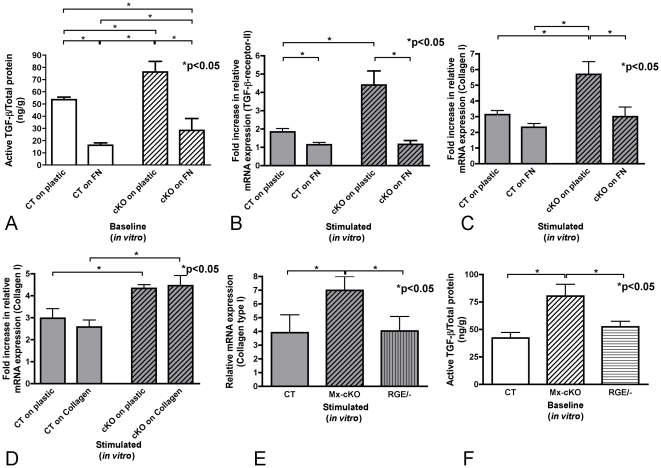
Fibronectin normalizes the responsiveness of cKO cells.(A) Active TGF-β in the medium decreases significantly both in control and Mx-cKO cells in the presence of fibronectin coating. Stellate cells were cultured directly after isolation for 24 hours on plates left uncoated or coated with fibronectin, media were changed and collected after an additional 24 hours in culture (using 10% fibronectin-depleted FCS). N = 5 wells/group. (B) Fibronectin coating is associated with a decrease in TGF-β-receptor-II mRNA expression in response to TGF-β stimulation in Mx-cKO cells. Isolated cells were cultured on plastic or on fibronectin for 24 hours, then left untreated or treated with 10 ng/ml TGF-β for an additional 24 hours after which mRNA was collected. Data presented are adjusted to unstimulated cells to facilitate comparison. N = 6/group. (C) Fibronectin coating normalizes the response of cKO cells to TGF-β stimulation. No difference in the responsiveness to TGF-β stimulation in the presence of fibronectin coating between CT and Mx-cKO cells is seen, while cKO cells cultured on plastic show a higher responsiveness to TGF-β than CT cells on plastic. Cells were cultured and data are presented as in B. N = 6/group. (D) Collagen coating does not affect the response of cells to TGF-β. Therefore, cKO cells continue to show an increase in responsiveness to TGF-β that is unrelated to the presence or absence of collagen coating. Cells were cultured and data are presented as in B. N = 4/group. (E) The presence of fibronectin fibrils with mutated RGD domain and hence unable to activate integrins via RGD is enough to result in normal amounts of collagen production in response to TGF-β stimulation. Deletion of fibronectin in mice with the genotype Mx-cre/- FN-RGE/fl resulted in cells that only express one mutated fibronectin (RGE/-). Cells were treated with TGF-β and collagen-type-I examined by qPCR. N = 6–7/group. (F) The presence of fibronectin with an RGE mutation is enough to normalize the levels of active TGF-β in the conditioned media. Cells were cultured as in A. N = 6–7/group.